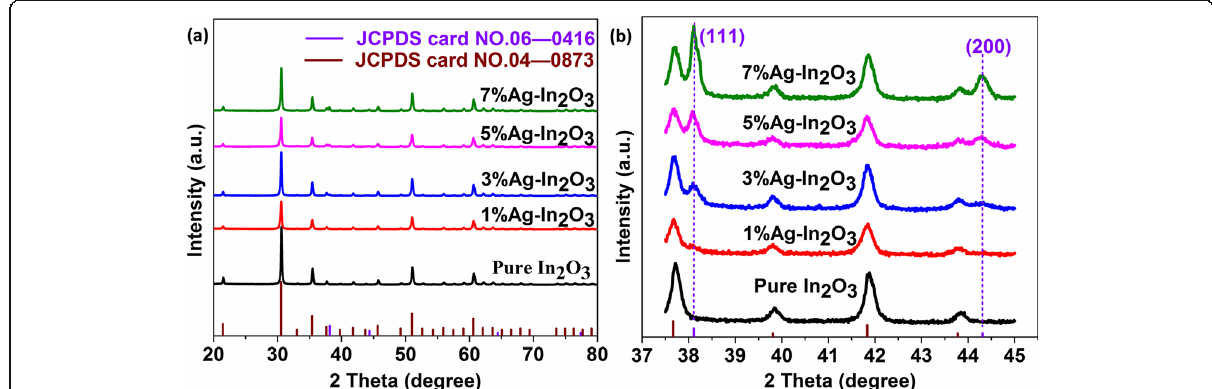
Fig. 2 a XRD patterns of pure In 2 O 3 , 1%Ag-In 2 O 3 , 3%Ag-In 2 O 3 , 5%Ag-In 2 O 3 , and 7%Ag-In 2 O 3 samples. b Corresponding high magnification of the 111 and 200 peaks of the samples